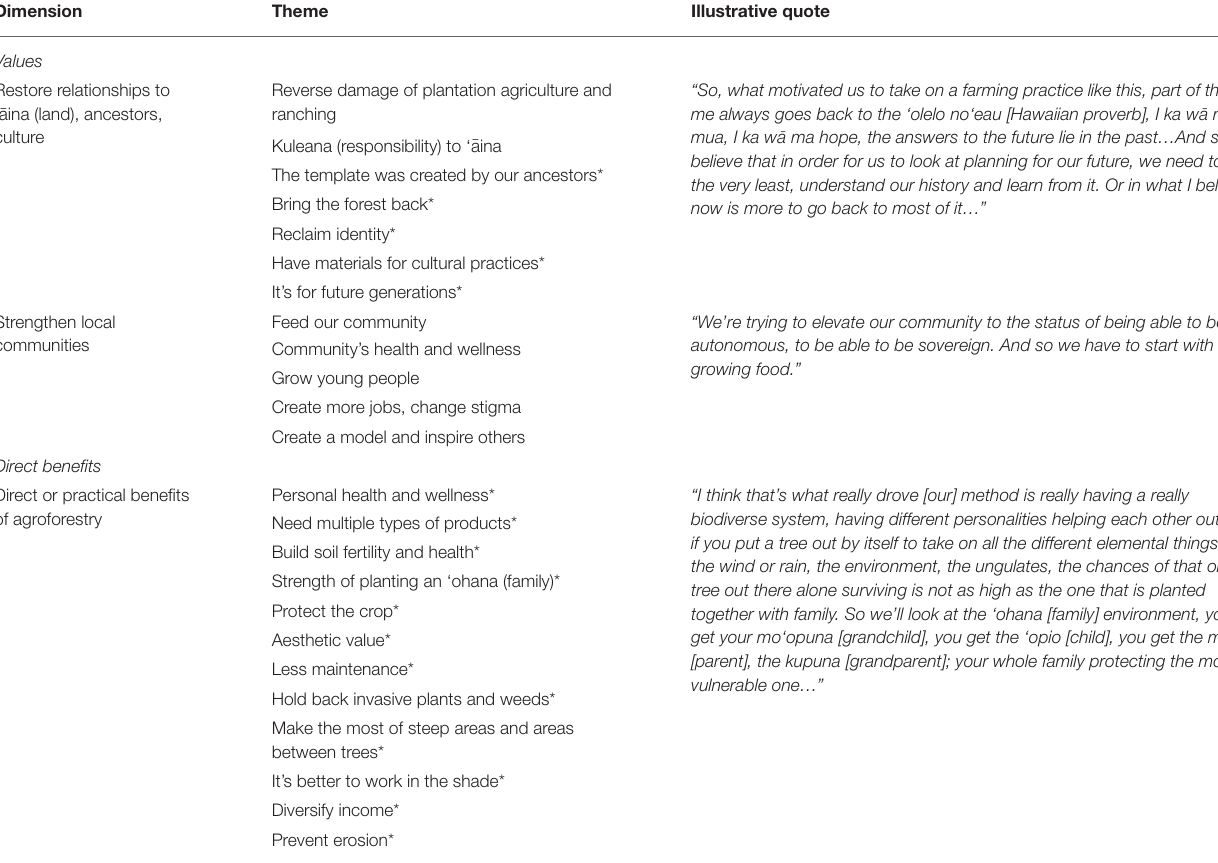
TABLE 1 | Factors motivating people to transition to agroforestry in Hawai‘i. Some motivators represent values and visions for change that could be achieved through multiple forms of agroecology or sustainable agriculture, not just agroforestry. Practitioners also gave reasons that related to agroforestry specifically (denoted with